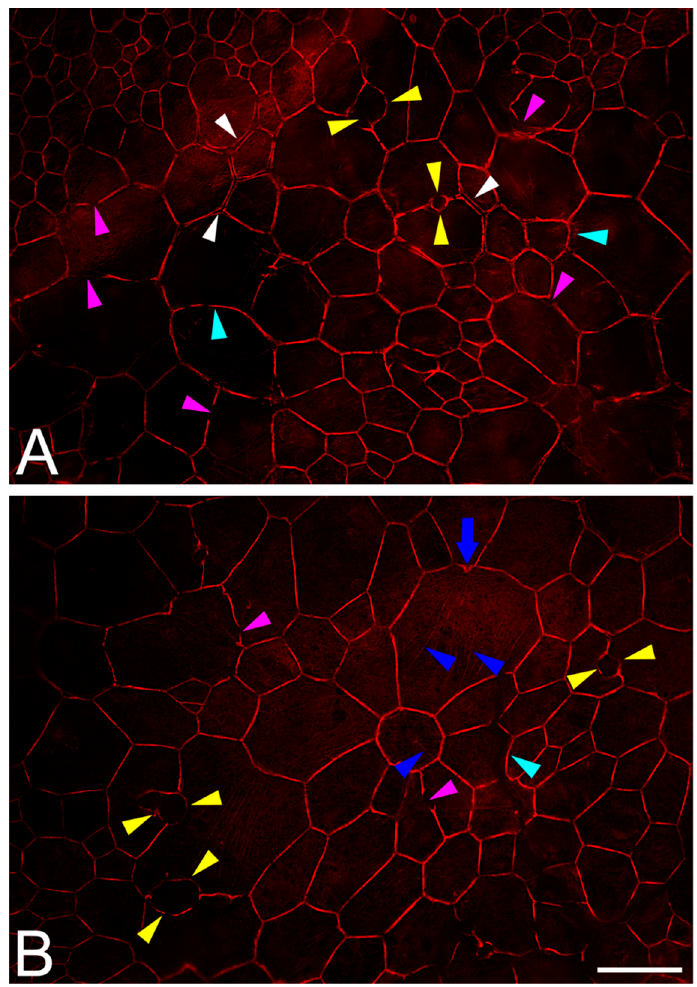
Figure 3. RPE cytoskeleton alterations in age-related macular degeneration (AMD). In contrast to the normal architecture and to age-related changes in RPE geometry (Figure 1), patchy areas with loss of the cells’ regular polygonal geometry and shape arise at AMD lesions ( A,B ). Prima facie, especially enlarged cells with a partly roundish shape (turquoise arrowheads) and variable irregular phenotypes are present. The ‘railroad tracks’-like arrangement of adjacent cells´ cytoskeleton bands is altered, showing separation (white arrowheads) and fragmentation or interruption (pink arrowheads). A special separation is sporadically seen: a splitting of the cytoskeleton (yellow arrowheads), which starts as small roundish lesions which then enlarge and finally might lead to a complete separation of two cells. A common finding in altered RPE cells is the presence of intracellular stress fibers (in B , blue arrowheads). At the insertion sites of the stress fibers, the actin filament cytoskeleton appears frayed and thickened (blue arrow). Donor: 83 years, female. RPE cells from the parafovea. F-actin labeled with AlexaFluor647-Phalloidin. Scale bar: 50 µm.